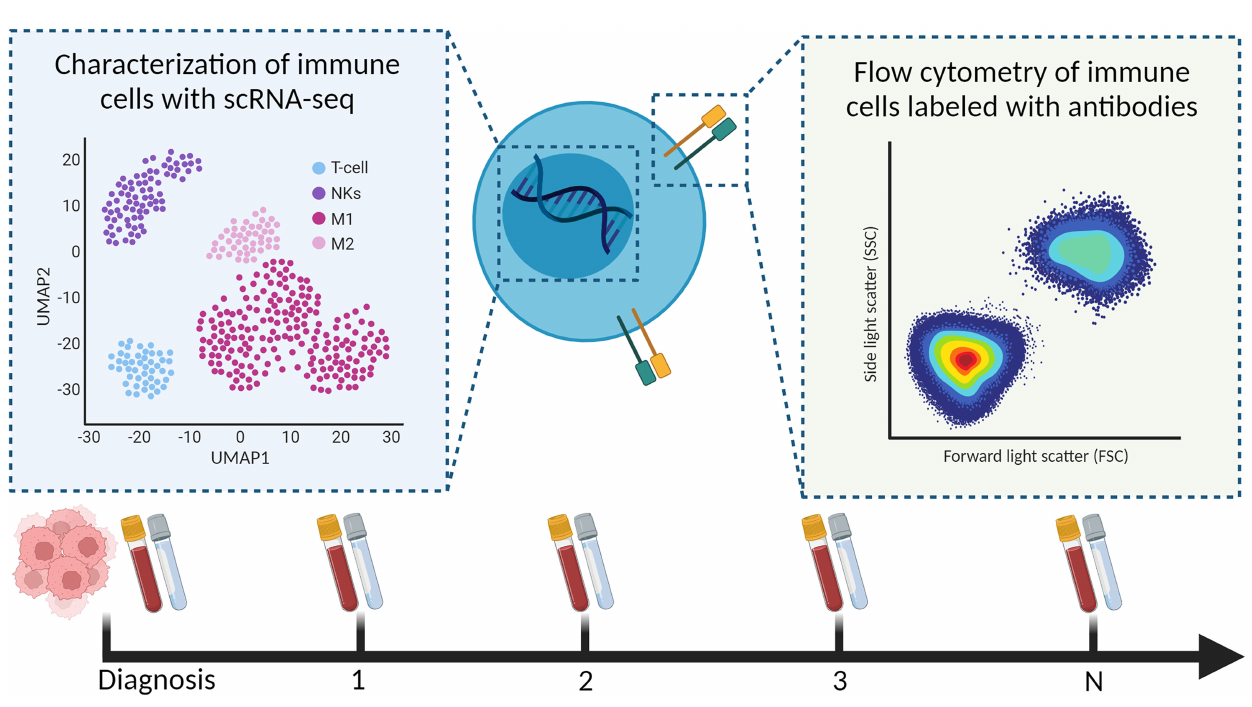
FIGURE 4 | Characterization of immune cells from longitudinal liquid biopsies (as shown, blood and CSF) using scRNA-seq and fl ow